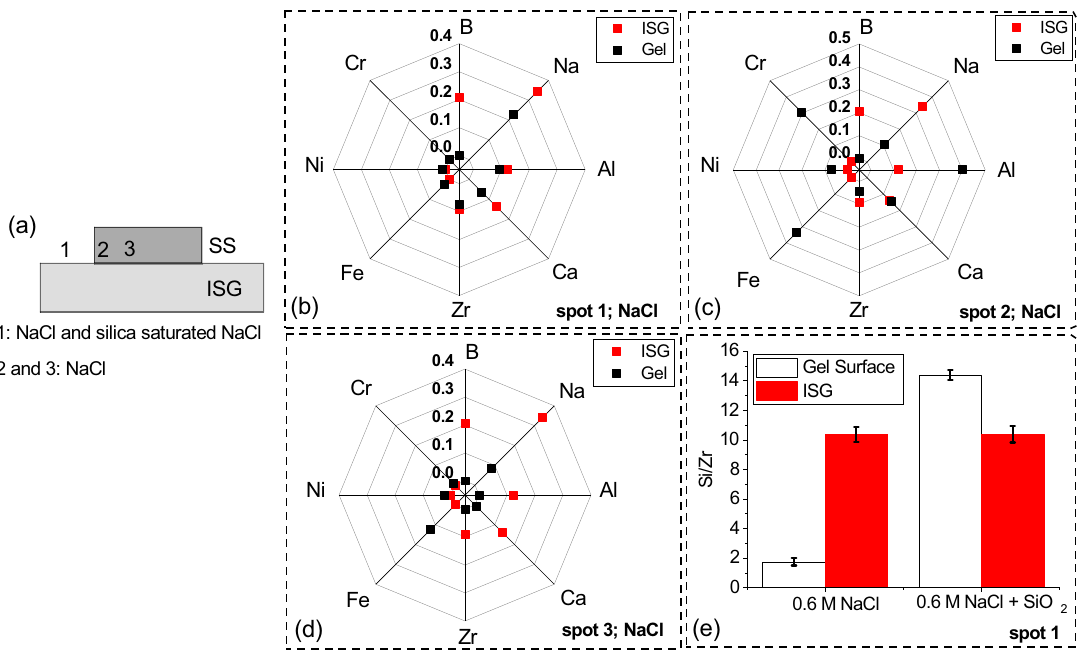
Fig. 9 Results of gel surface chemistry in terms of weight percent of elements obtained with XPS on glass gels and compared with pristine ISG. a ) An illustration of the ISG( + SS) creviced assembly where the numbers 1, 2 and 3 represent the spots at which XPS data were acquired. For spot 1, data were collected for ISG samples corroded in NaCl as well in silica-saturated NaCl. For spots 2 and 3, the data were collected only for NaCl solution. Note that spot 3 is closer to the crevice mouth than the crevice center. b – d ) The elemental composition of gel surface normalized to that of Si at regions 1, 2 and 3 in 0.6 M NaCl, respectively. e ) The weight percent of Si normalized to that of Zr for gel surface at spot 1 for NaCl as well as silica saturated NaCl compared with that of uncorroded